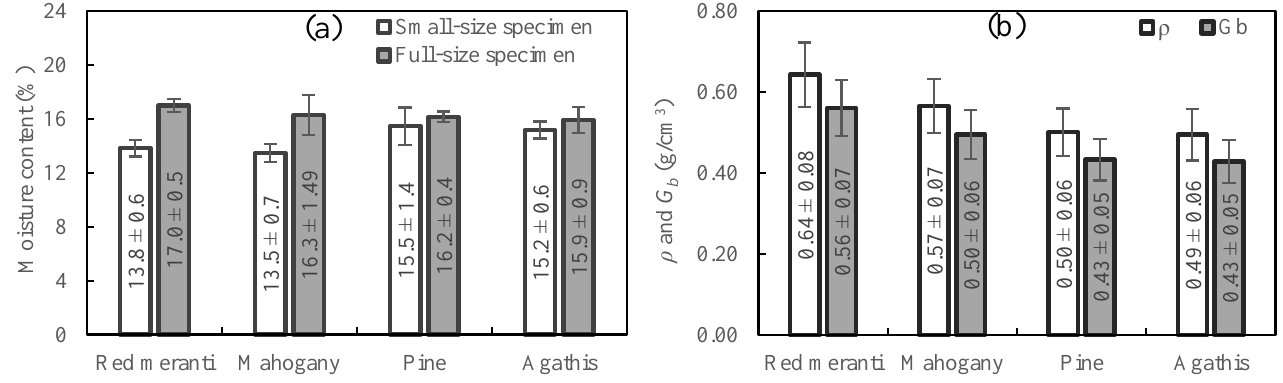
Figure 4. ( a ) Air-dry moisture content ( M c ); ( b ) density ( ρ ) and specific gravity ( G b ).